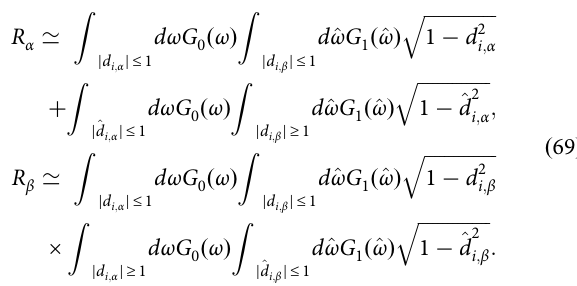
ffiffiffiffiffiffiffiffiffiffiffiffiffiffiffi